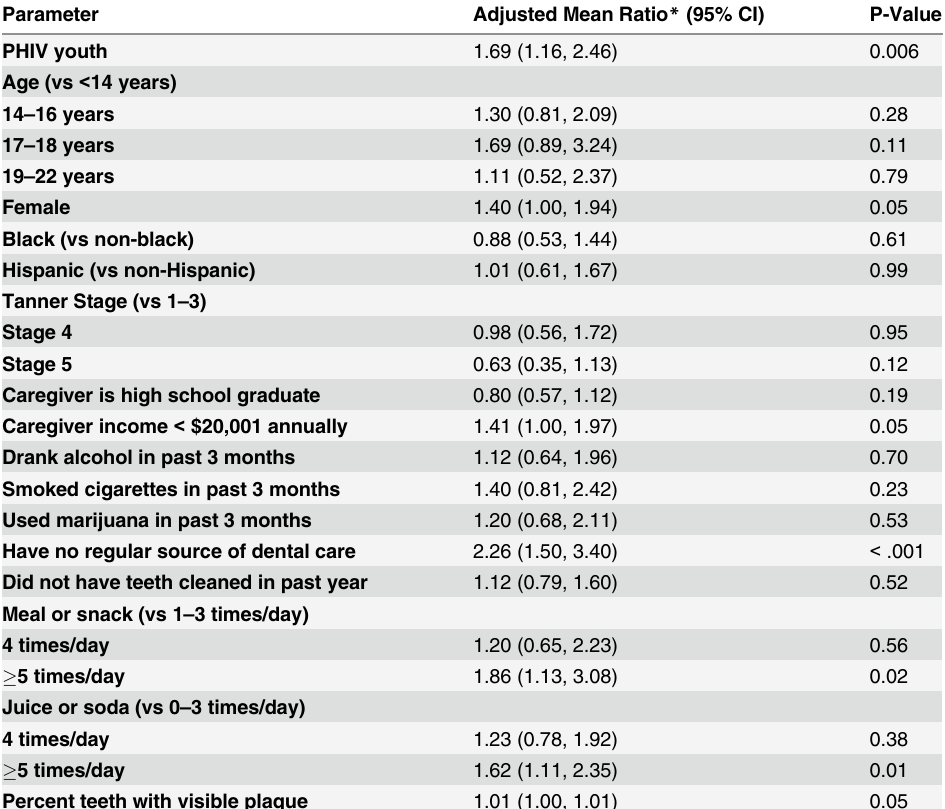
Table 5. Zero-inflated negative binomial multivariable model of number of decayed teeth (DT) (N = 312).